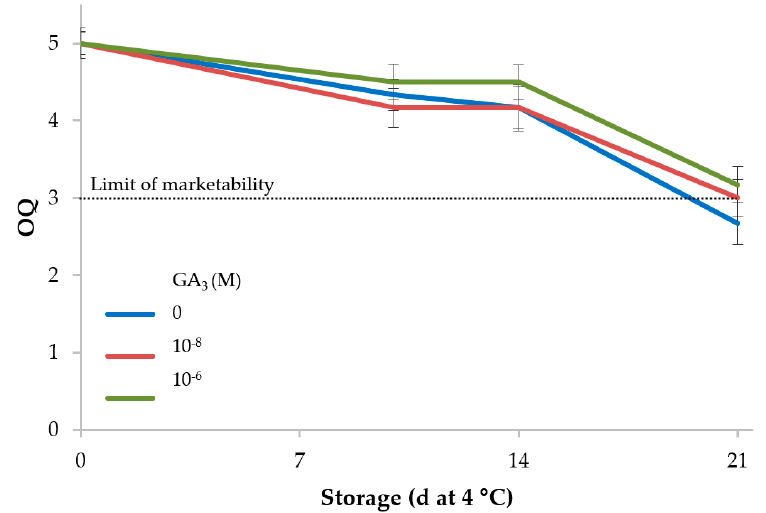
Figure 2. Influence of GA 3 treatments and storage at 4 °C on overall quality of minimally processed rocket (5: excellent or having a fresh appearance; 3: average—limit of marketability; 1: